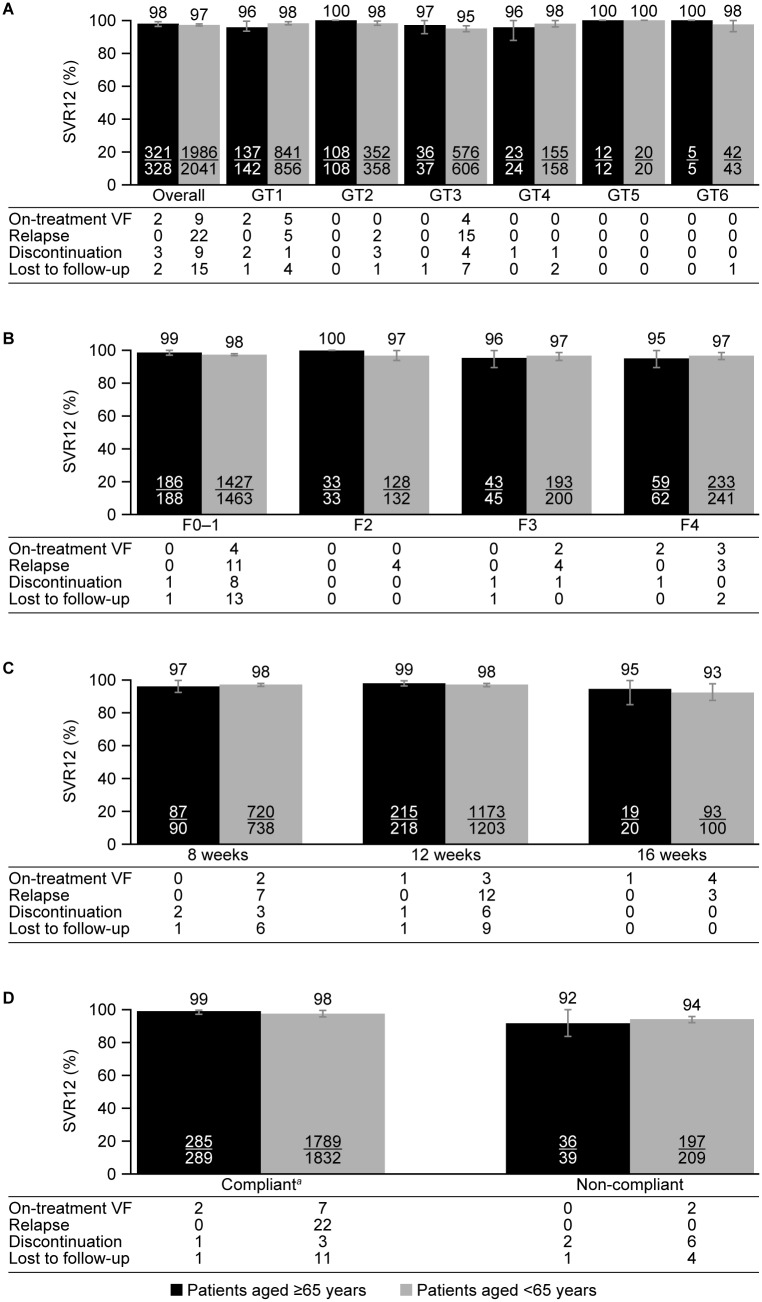
Sustained virologic response at post-treatment week 12 by A) hepatitis C virus genotype; B) fibrosis stage; C) glecaprevir/pibrentasvir treatment duration; and D) glecaprevir/pibrentasvir treatment compliancea (ITT analyses). aCompliant was defined as 80%–120% of expected glecaprevir/pibrentasvir intake. F, fibrosis stage; GT, genotype; ITT, intention-to-treat; SVR12, sustained virologic response at post-treatment week 12; VF, virologic failure.